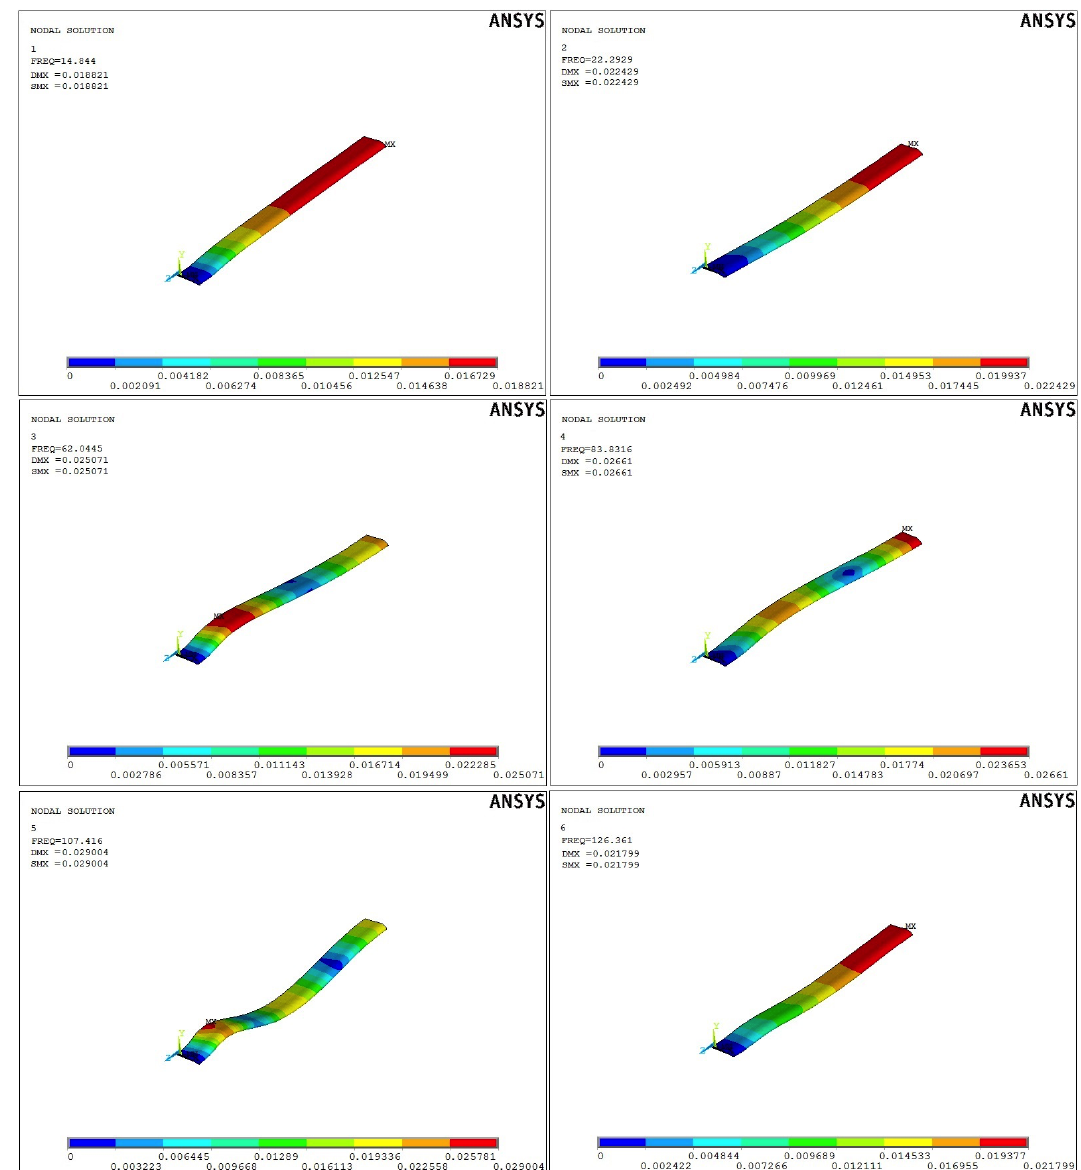
Figure 9. Mode shapes of the